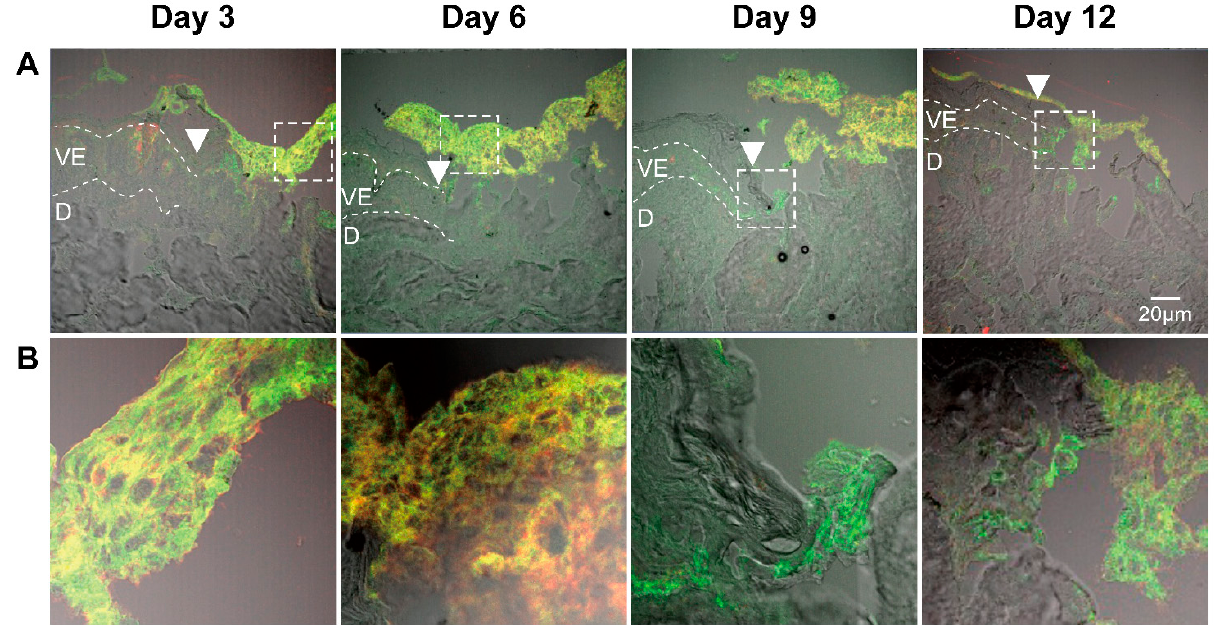
Figure 3. Identification of ASCs in wounds after topical application. Sections of wounds after different incubation days with topically applied ASCs. ( A ) Images of the wound edges taken with 20× magnification. Dotted lines show the viable epidermis and white arrowheads point to the wound edges. VE, viable epidermis; D, dermis. All pictures were taken with the same magnification; scale bar, 20 μ m. ( B ) Five time magnification of the boxed areas in A .